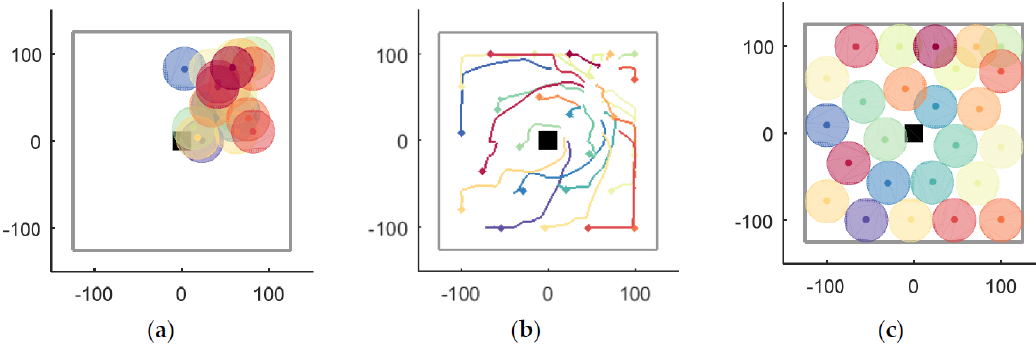
Figure 14. The process of coverage with obstacle Ω o . ( a ) The initial positions; ( b ) The moving